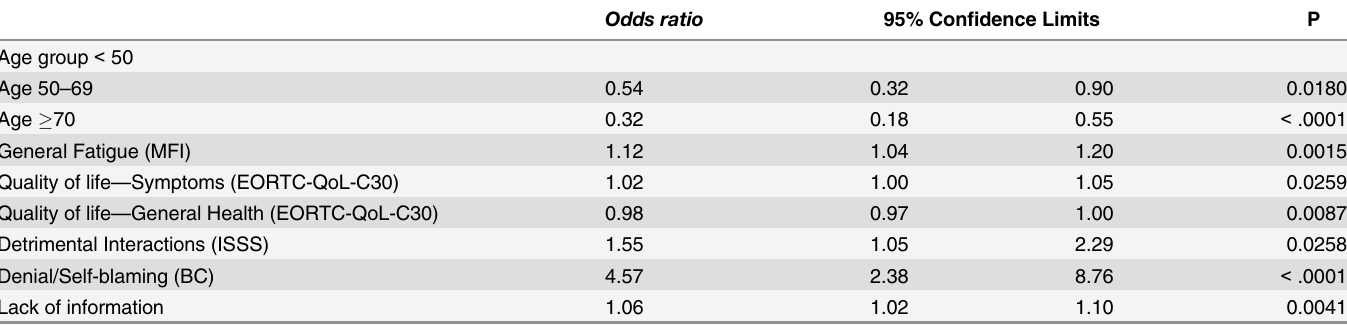
Table 3. Predictors of the need for psychosocial care: Multivariable logistic regression based on multiple imputation (10 imputation data sets, Nagelkerkes R 2 .41-.44). Odds ratio 95% Con fi dence Limits P